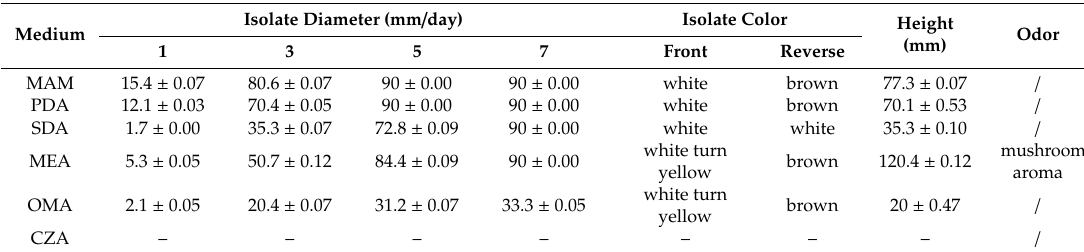
Table 2. Growth characteristics of A. jiangsuensis on di ff erent media.